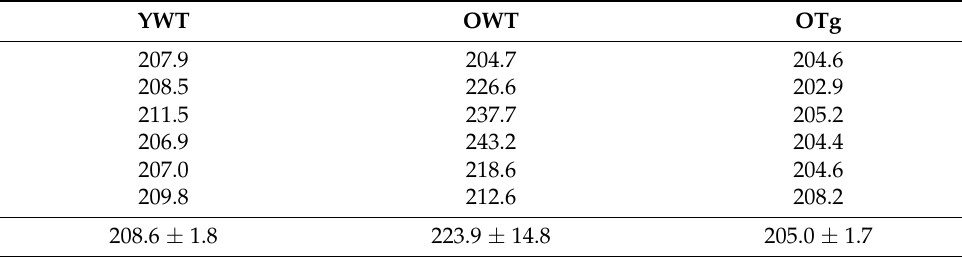
Figure 6. Representative microphotographs from histological sections of aorta. ( A ) Hematoxylin- eosin. ( B ) Orcein staining. ( C ) Masson’s trichrome. 1: Young WT samples. 2: Old WT samples. 3: Old G6PD-Tg samples. Results are representative of n = 6 per group.